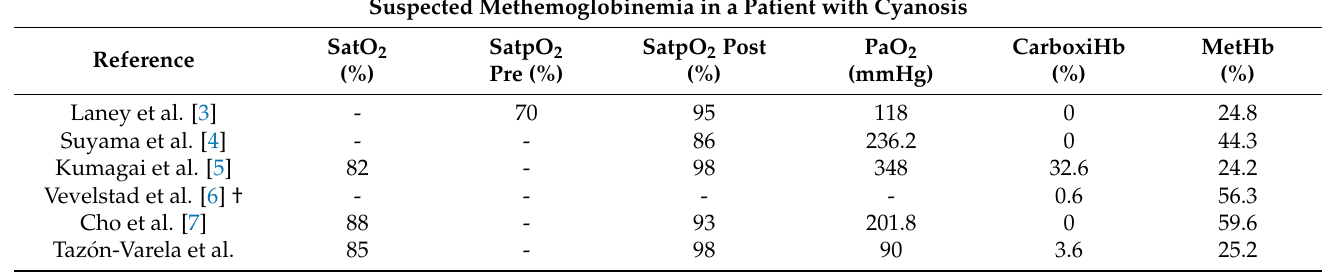
Table 2. Pulse oximetry, blood gases, and co-oximetry in Methemoglobinemia. Suspected Methemoglobinemia in a Patient with